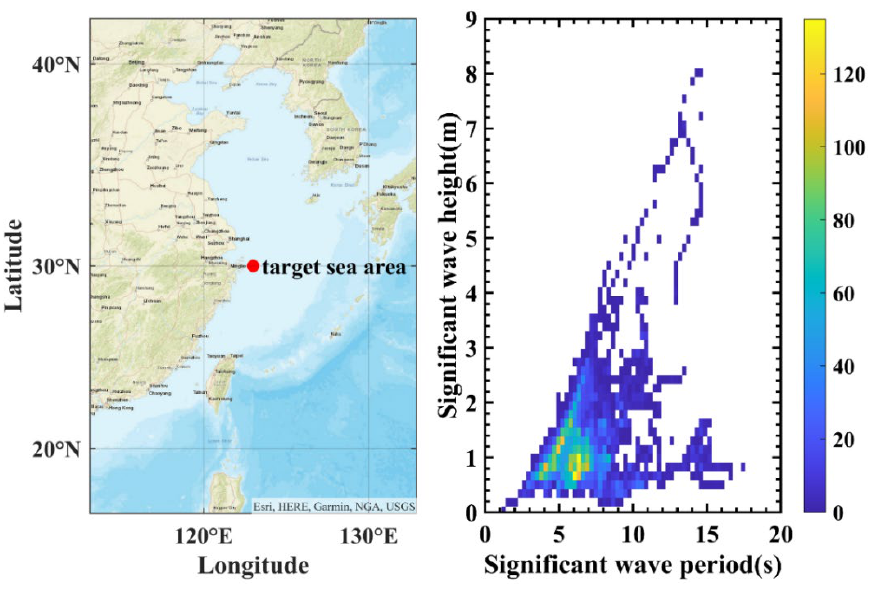
Figure 3. Statistical of sea state.